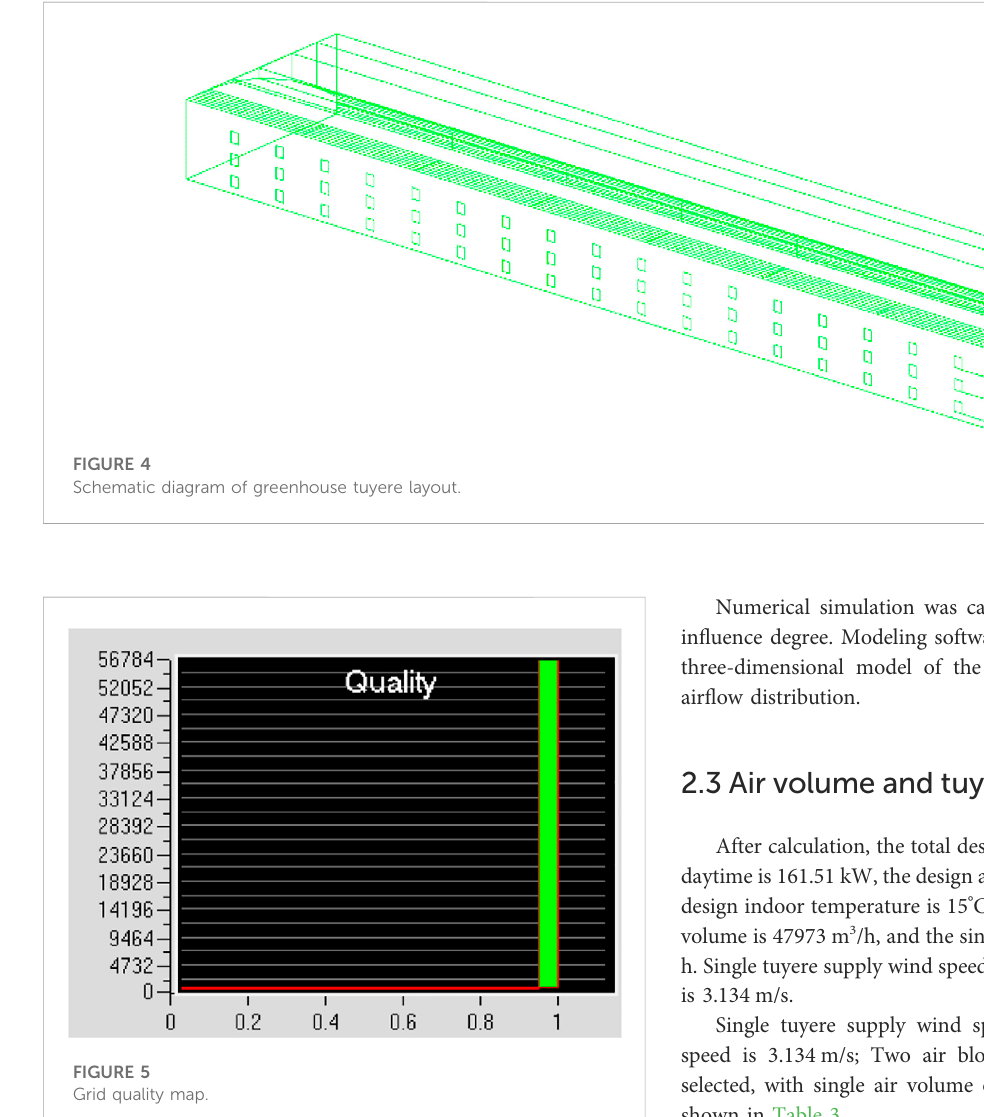
FIGURE 5 Grid quality